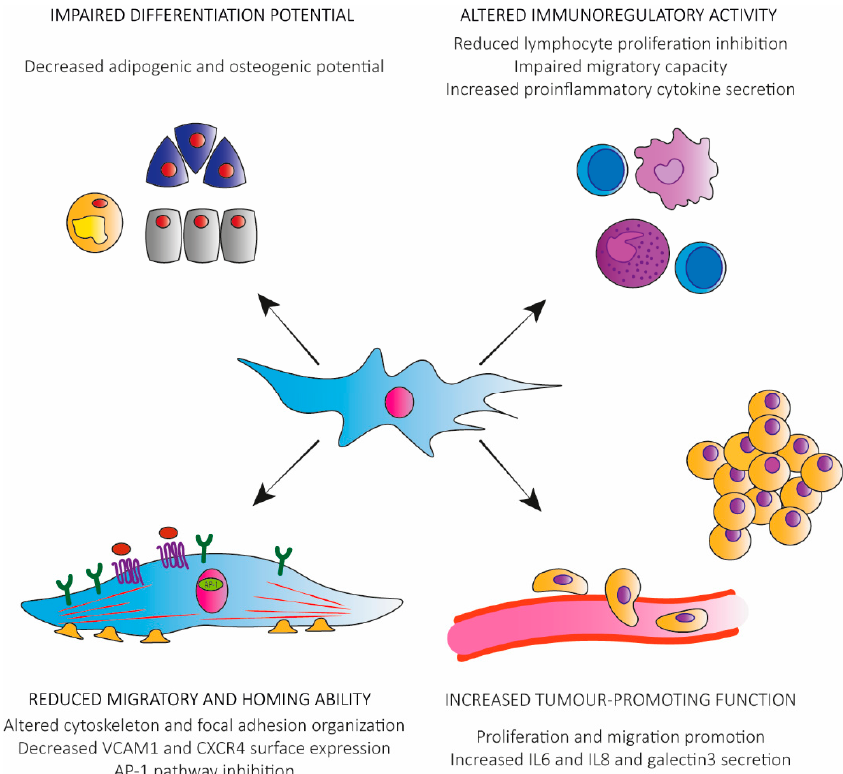
Figure 2. Functional alterations occurring in senescent hMSCs. Senescent hMSCs exhibit impaired differentiation potential, altered immunoregulatory activity, reduced migratory, and homing ability, and increased tumour-promoting functions.